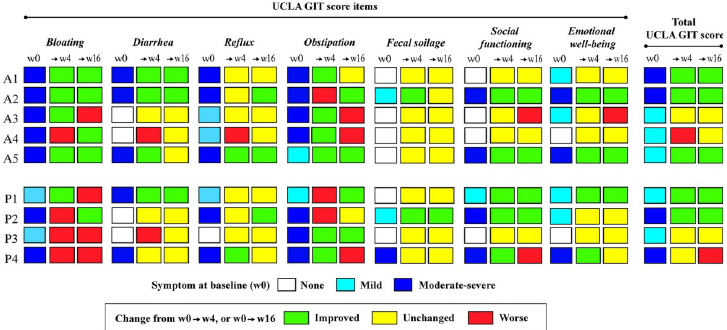
Fig 2. Clinical efficacy of fecal microbiota transplantation (FMT) on gastrointestinal (GI) symptoms. Efficacy of FMT measured by the total UCLA GIT score and all seven items of the UCLA GIT score (bloating, diarrhea, reflux, obstipation, fecal soilage, social functioning and emotional well being). Patients receiving FMT (active treatment) marked as A and placebo marked as P. Symptoms at baseline (week 0; w0) are segregated into dark blue (moderate- severe), light blue (mild) and white (no) GI symptoms. Changes to week 4 and week 16 are marked in green (improved), yellow (stable) or red